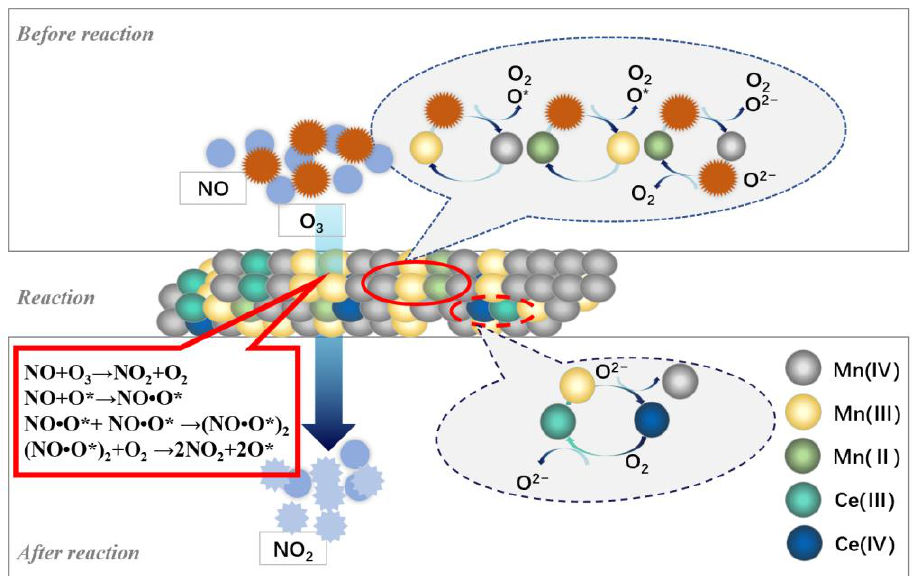
Figure 7. Reaction pathway of Mn-Ce/Al 2 O 3 /TiO 2 synergistic ozone oxidation of NO.